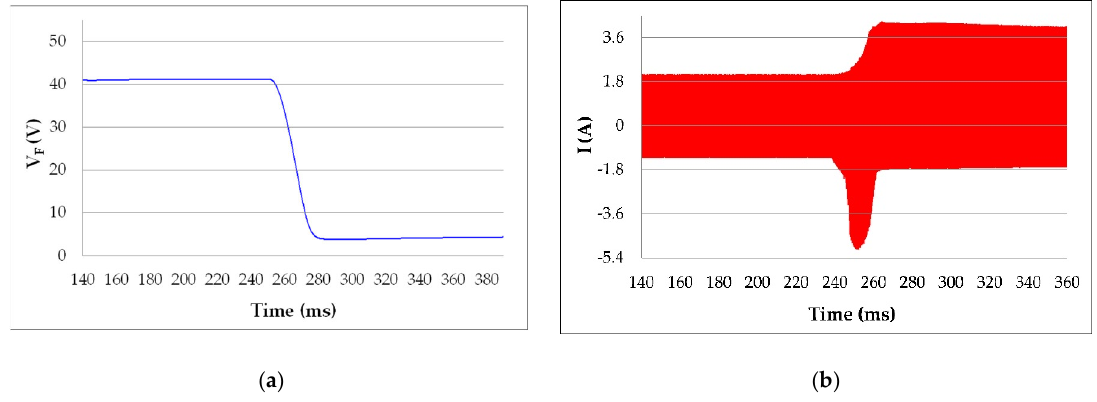
Figure 10. ( a ) 𝑉 (cid:3007) ; ( b ) the current of 𝐿 (cid:3007) when disconnecting from the load. Figure 10. ( a ) V F ; ( b ) the current of L F when disconnecting from the load.